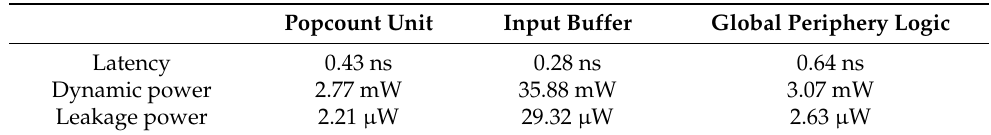
Table 1. Implementation